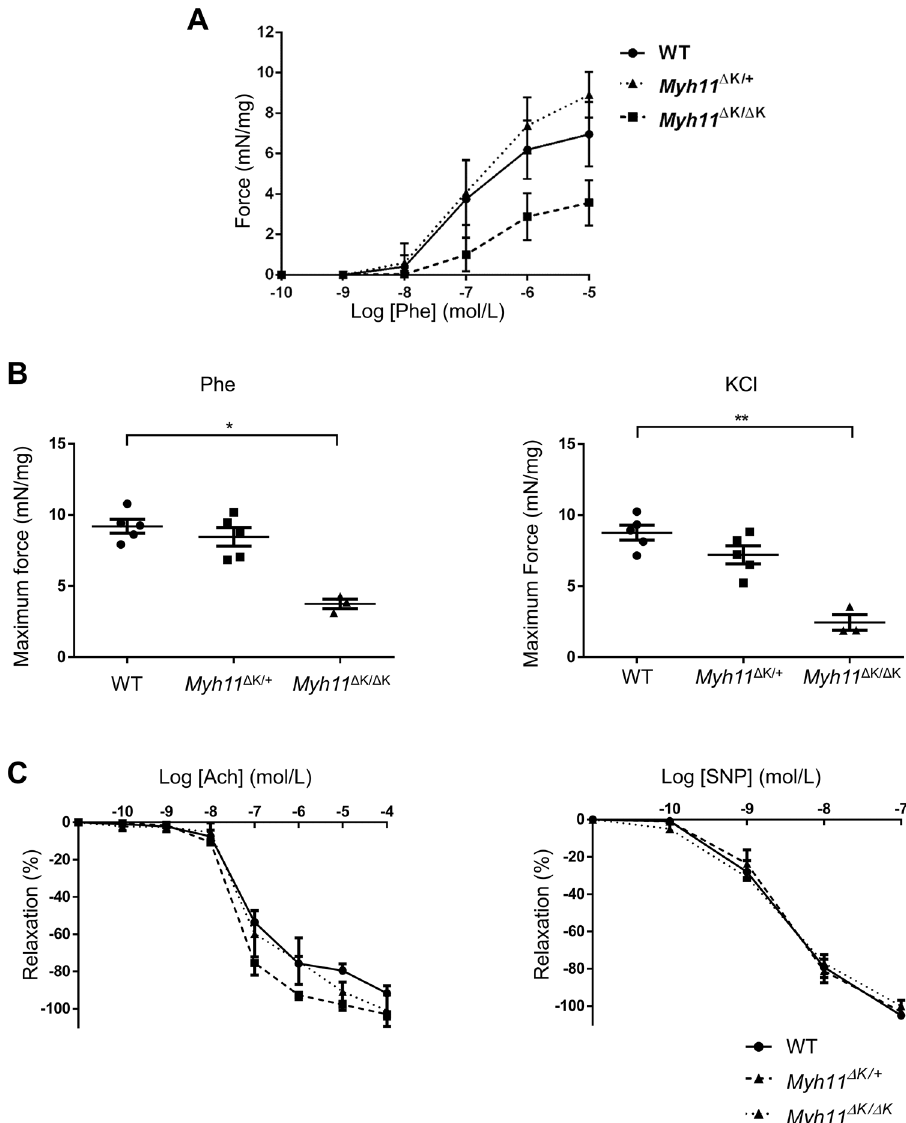
Figure 4. Myh11 K1256del attenuated contractile function in Myh11 ∆K/∆K SMCs. (A) Effect of Myh11 K1256del on the dose-dependent contraction of aortas induced by phenylephrine (Phe). Each point represents the mean ± SEM. (B) Scatter dot plot showing the means ± SD of maximum force that the WT, Myh11 ∆K/+ and Myh11 ∆K/∆K aortas produced after phenylephrine (Phe) or KCl treatment (WT and Myh11 ∆K/+ : n = 5; Myh11 ∆K/∆K : n = 3). * p < 0.05, Kruskal–Wallis test followed by Dunn’s multiple comparisons test. (C) Rate of relaxation of descending aortas in response to acetylcholine (ACh) and sodium nitroprusside (SNP) after the contractile response to 10 –5 mol/L Phe (WT and Myh11 ∆K/+ : n = 5; Myh11 ∆K/∆K : n = 3). There is no significant difference in the endothelium-dependent or endothelium-independent vasodilation between the WT and Myh11 ∆K/+